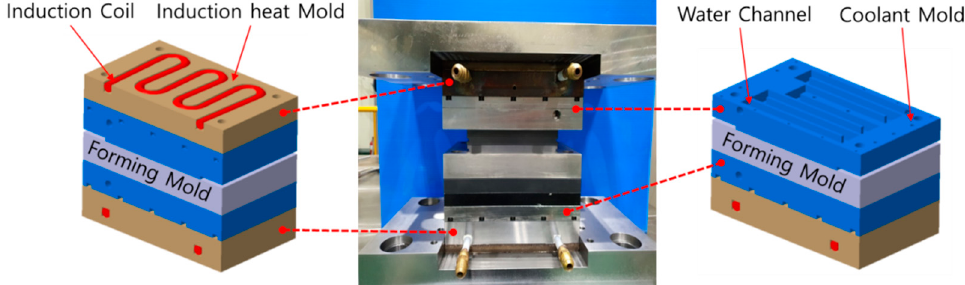
Figure 8. Schematic of the forming mold system used for rapid heating and cooling.